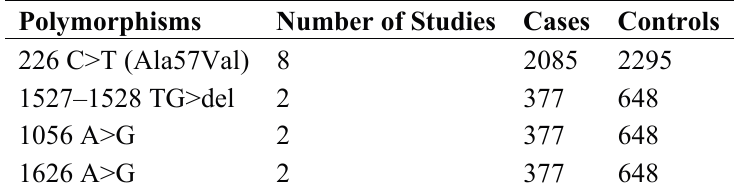
Table 1. Polymorphisms of the CD24 gene explored in the present study for their association with multiple sclerosis.